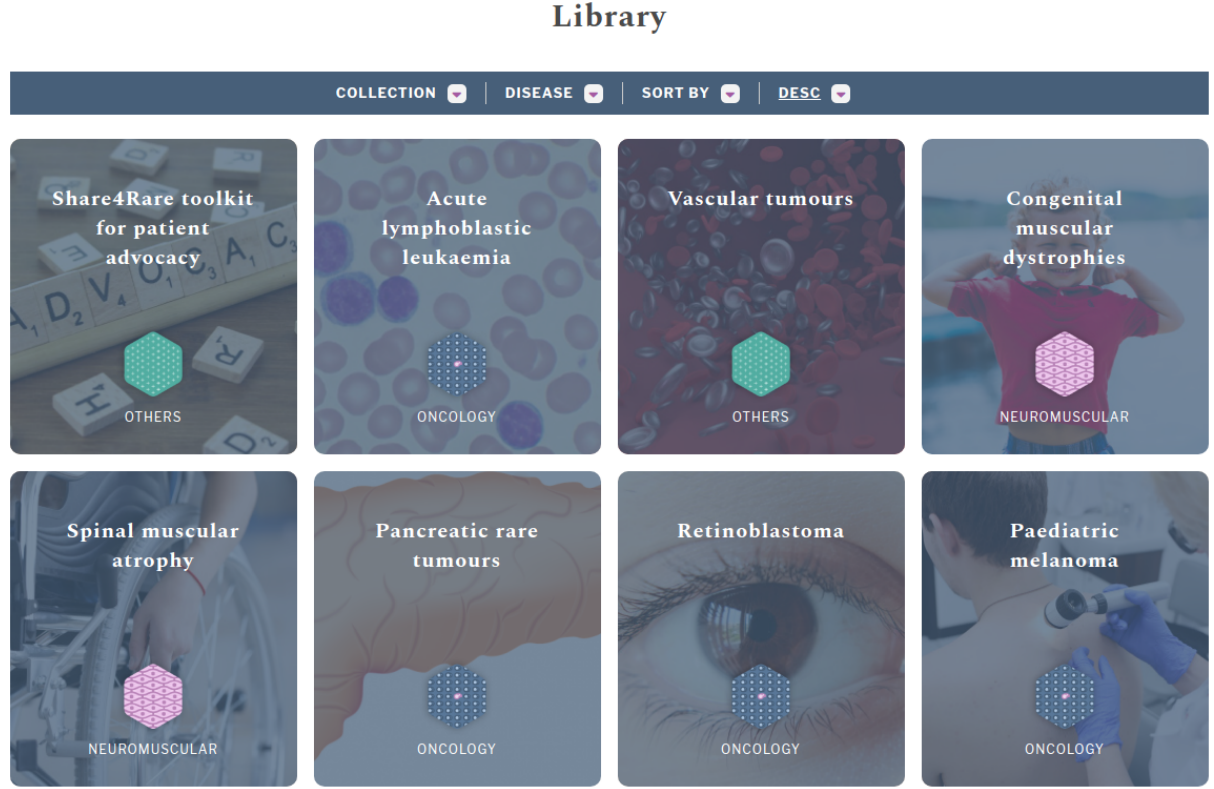
Figure 3. Screenshot showing some of the public medical materials available on